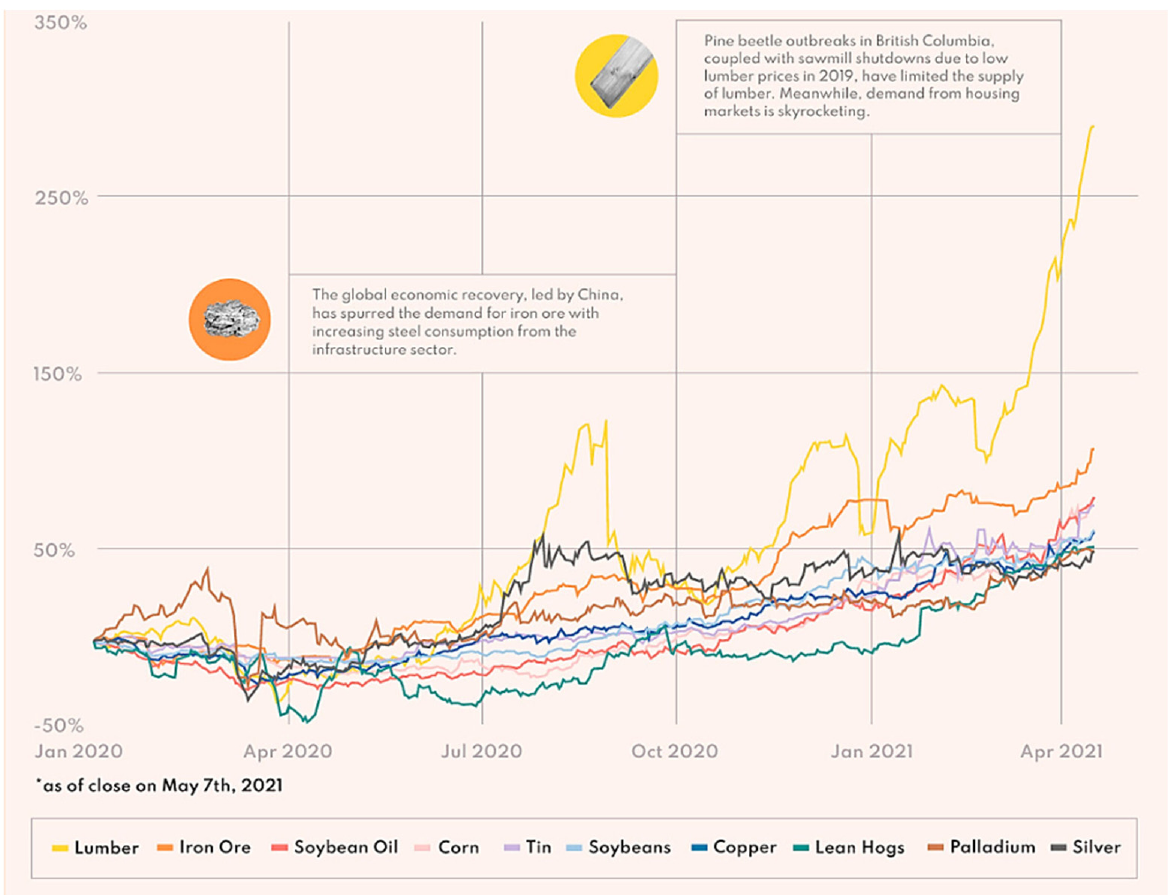
Figure 1. Percent change in commodity prices (1 January 2020–1 May 2021). Source: https://el- ments.visualcapitalist.com/visualizing-the-rise-in-commodity-prices/, (access date on 25 April